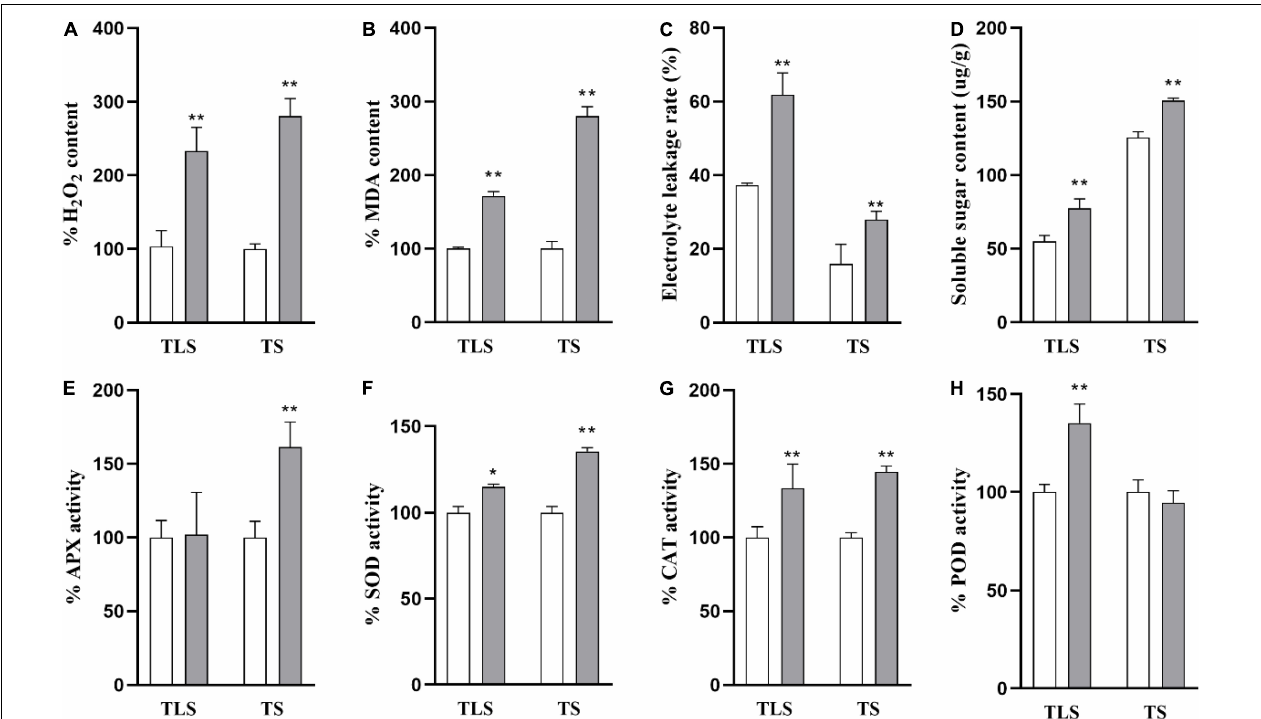
FIGURE 2 | The physiological changes of rice induced by spaceflight. (A) Percent values of H 2 O 2 . (B) Percent values of MDA. (C) The soluble sugar contents. (D) The electrolyte leakage rate change. (E) Percent values of APX activity. (F) Percent values of SOD activity. (G) Percent values of CAT activity. (H) Percent values of POD activity (TLS, three-leaf stage; TS, tillering stage; White column represents the control group; Gray column represents treatment group. The data (mean ± SD) are the means of three replicates with standard errors shown by vertical bars, n = 3, * and ** indicate significant difference at p < 0.05 and < 0.01 by student t -test, respectively.